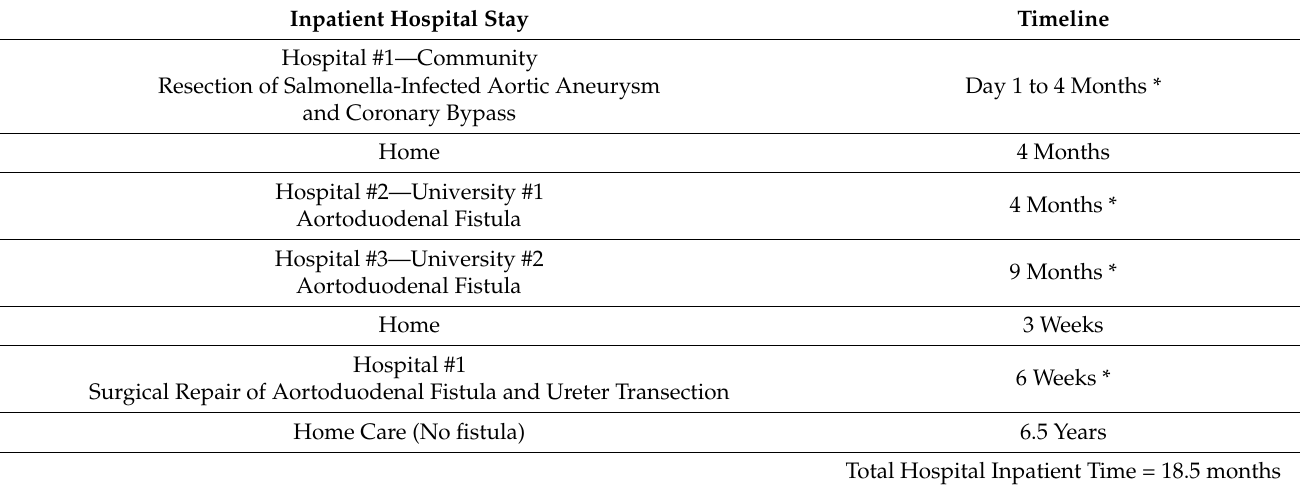
Table 1. Hospital Timeline of the Transected Ureter